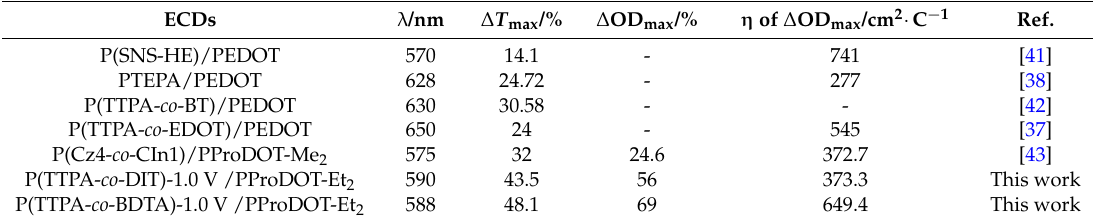
Table 7. The optical contrast, changes of the optical density and coloration efficiency of ECDs.